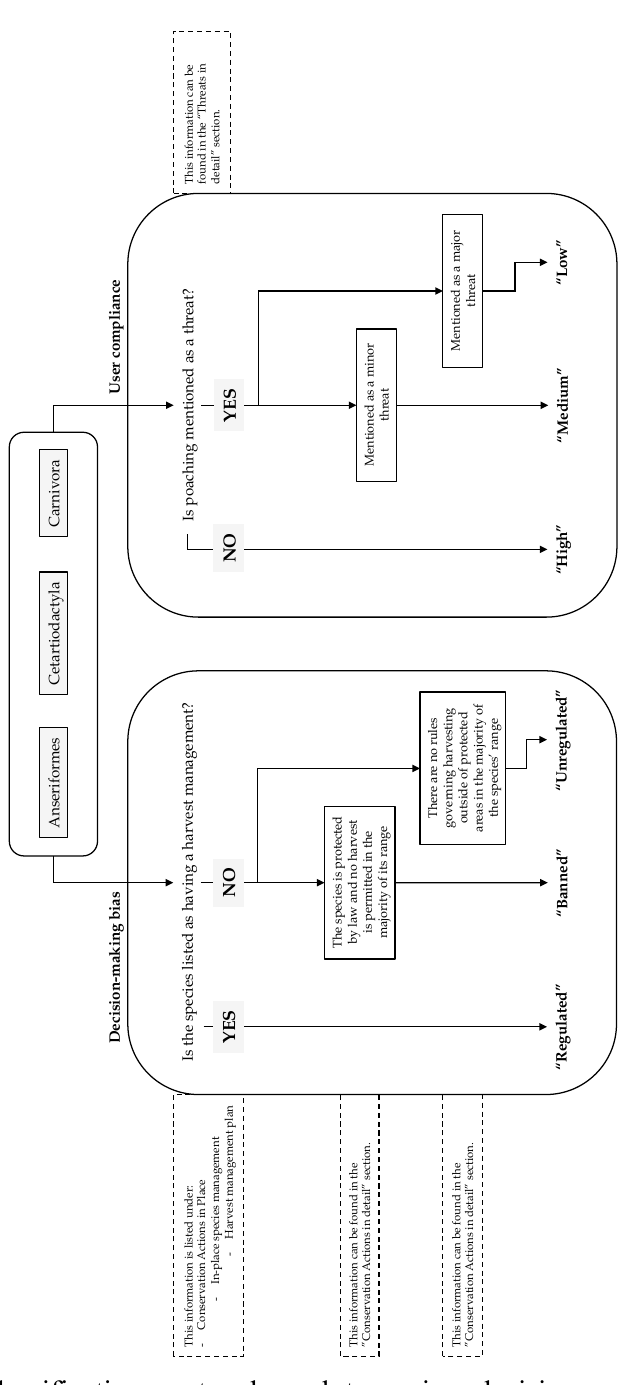
Fig. A4.1. Classification protocol used to assign decision-making bias and user compliance levels to harvested IUCN Red List